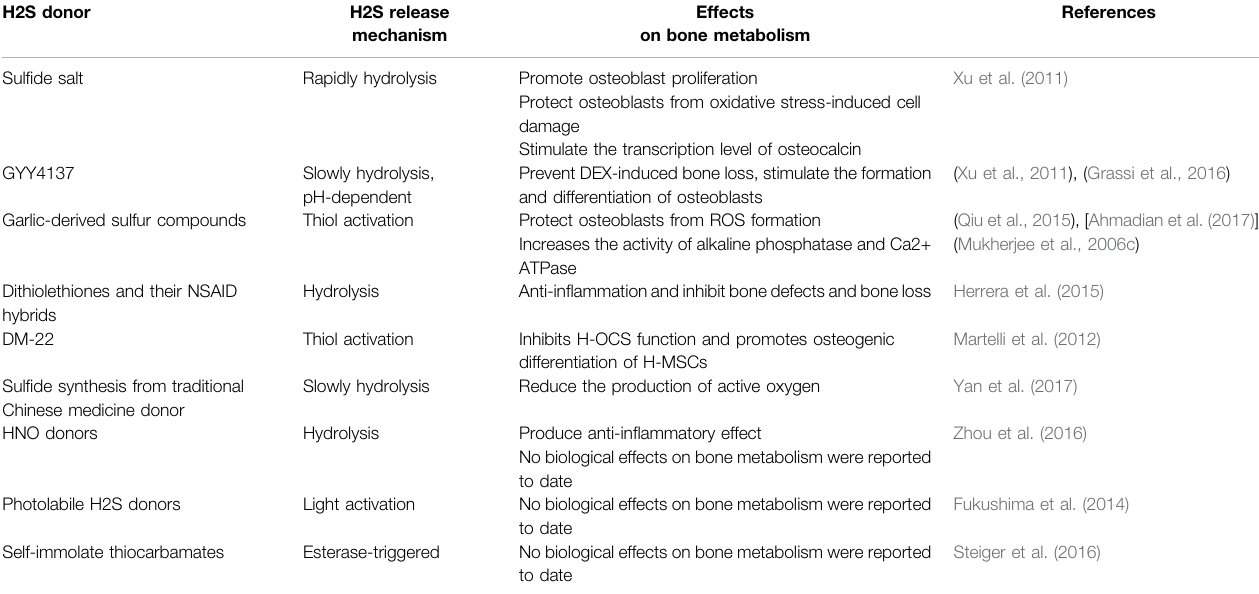
TABLE 1 | Summary of H2S